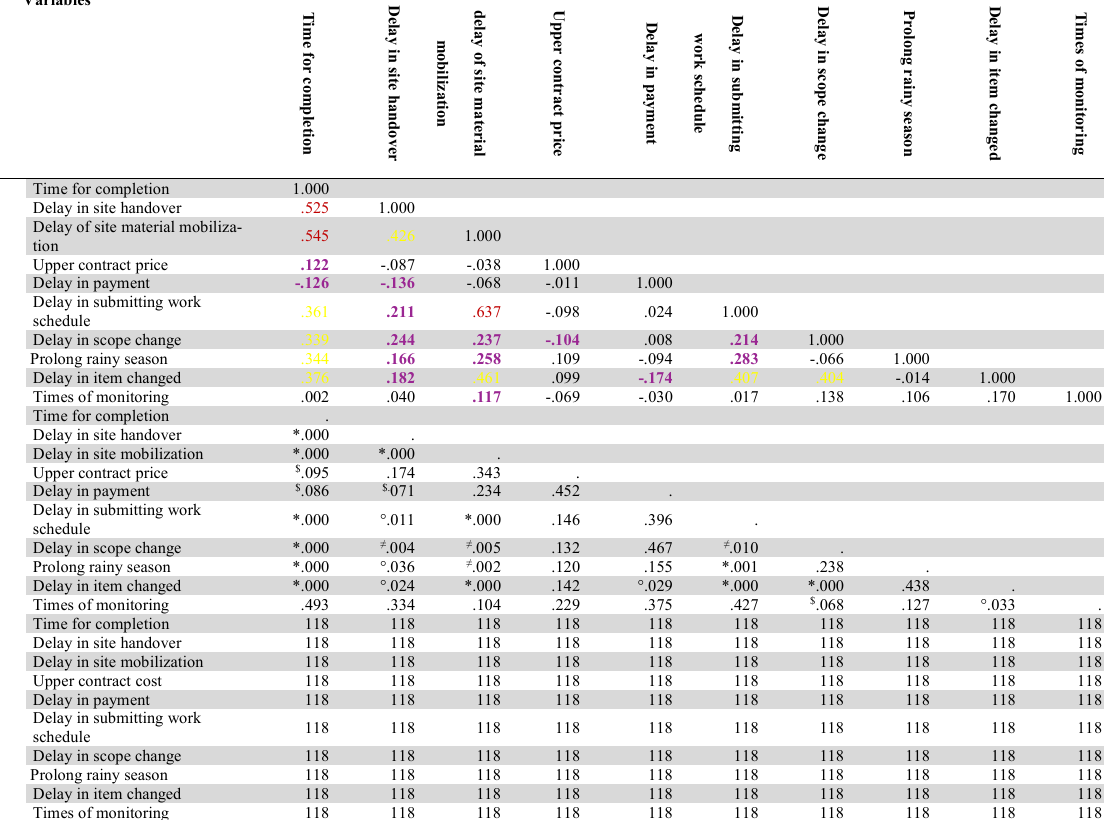
Correlations in case of dependent variables time for completion